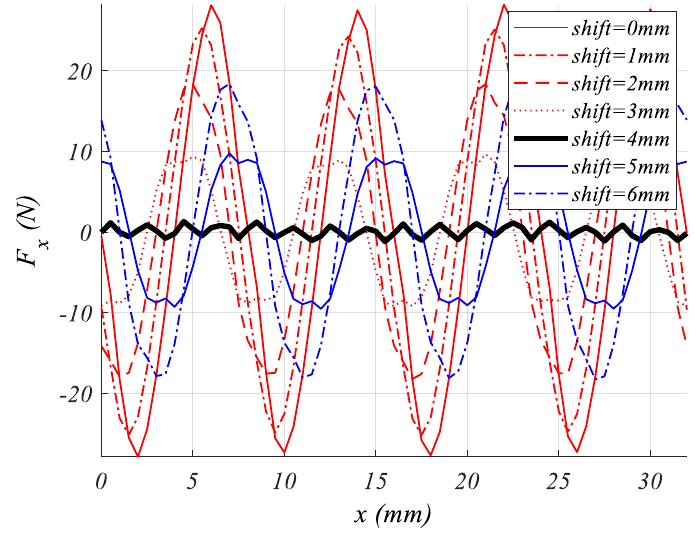
Figure 8. Detent force simulation results of the whole PM-LHRM.